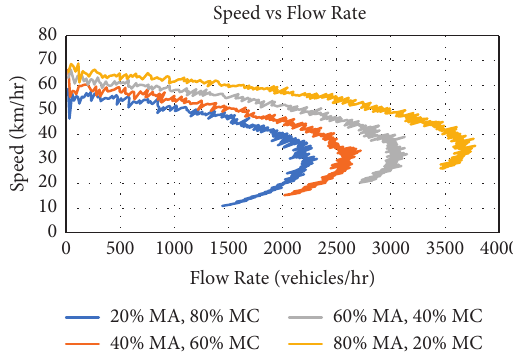
Figure 21: Speed vs. flow rate fundamental diagrams for different compositions of MA and